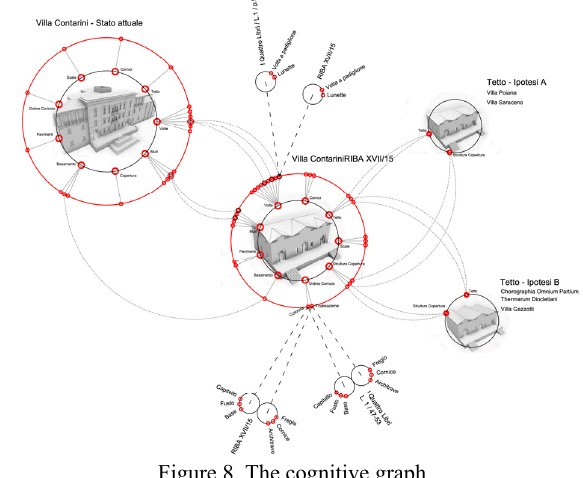
Figure 8. The cognitive